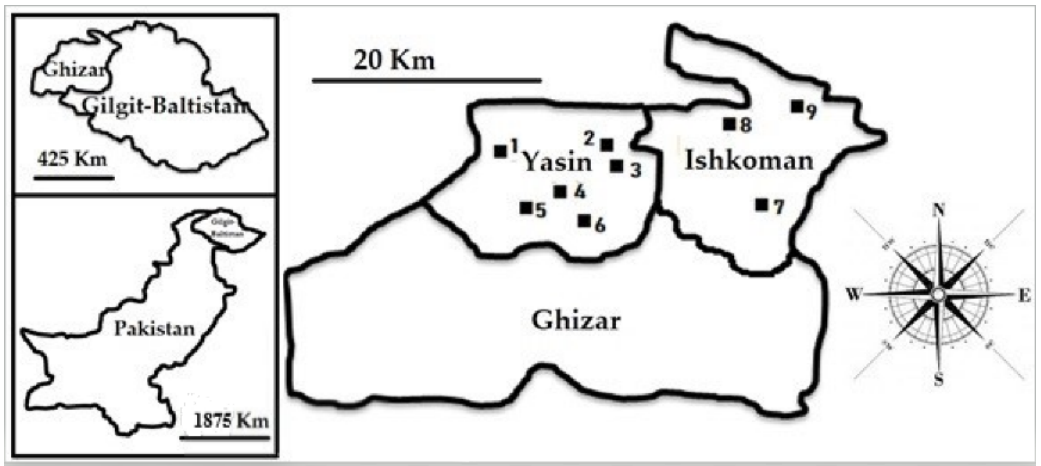
Figure 2. Map of the study area and visited villages: 1. Barkolti; 2. Sandi; 3. Ghojalti; 4. Sultan Abad;